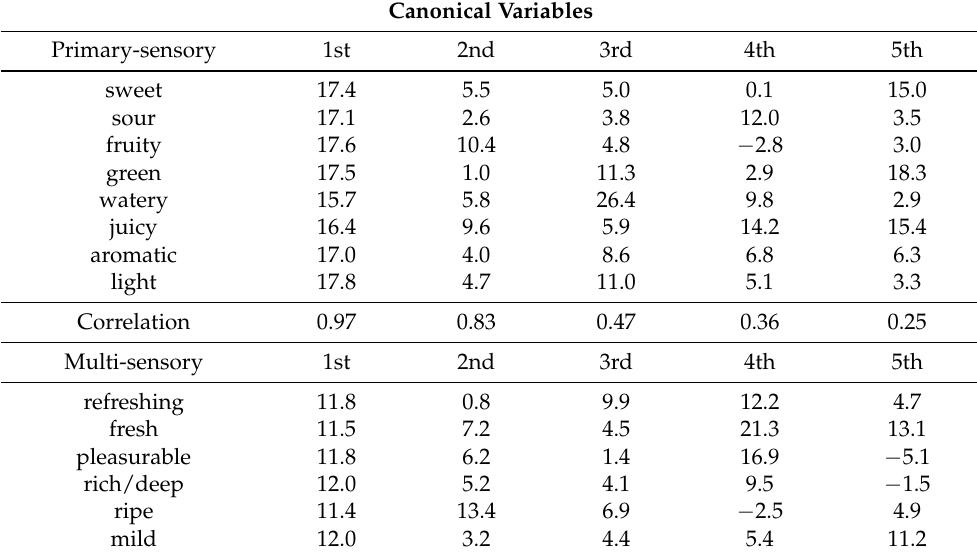
Table 4. Coefficients for 1st–5th canonical variables when the raw (i.e., trend) TDS curves were adopted for computing CCA. Correlation coefficients were computed between the two canonical variables for the primary- and multi-sensory attributes for each of the five canonical variables. Canonical Variables